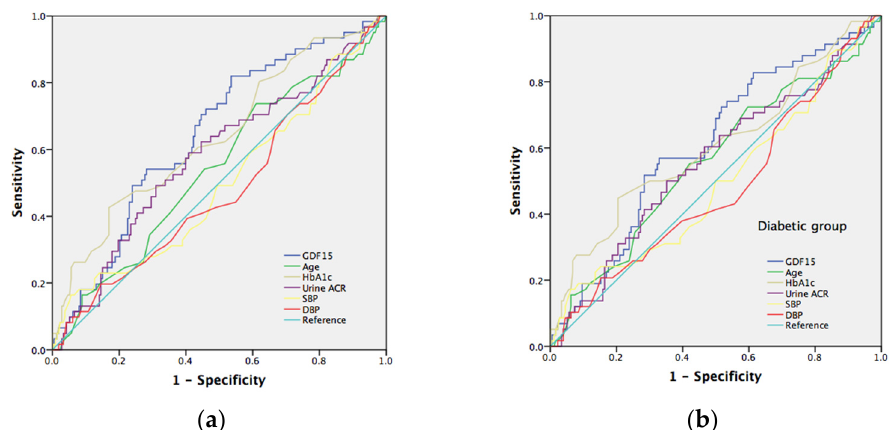
Figure 2. ( a ) Receiver operating characteristic (ROC) curves and area under the curve (AUC) in predicting tibial motor neuropathy. Blue line: GDF15 risk score (AUC = 0.646; p = 0.001); green line: age risk model (AUC = 0.540; p = 0.342); yellowish-green line: HbA1c risk model (AUC = 0.639; p = 0.001); purple line: urine albumin/creatine risk model (AUC = 0.579; p = 0.060). Yellowish line: systolic blood pressure risk model (AUC = 0.498; p = 0.969). Red line: urine diastolic blood pressure risk model (AUC = 0.481; p = 0.644); light blue line represents the reference line. ( b ) Receiver operating characteristic (ROC) curves and area under the curve (AUC) in prediction of tibial motor neuropathy. Blue line: GDF15 risk score (AUC = 0.610; p = 0.012); green line: age risk model (AUC = 0.557; p = 0.193); yellowish-green line: HbA1c risk model (AUC = 0.604; p = 0.018); purple line: urine albumin/creatine risk model (AUC = 0.557; p = 0.193). Yellowish line: systolic blood pressure risk model (AUC = 0.496; p = 0.923). Red line: urine diastolic blood pressure risk model (AUC = 0.476; p = 0.589); light blue line represents the reference line.